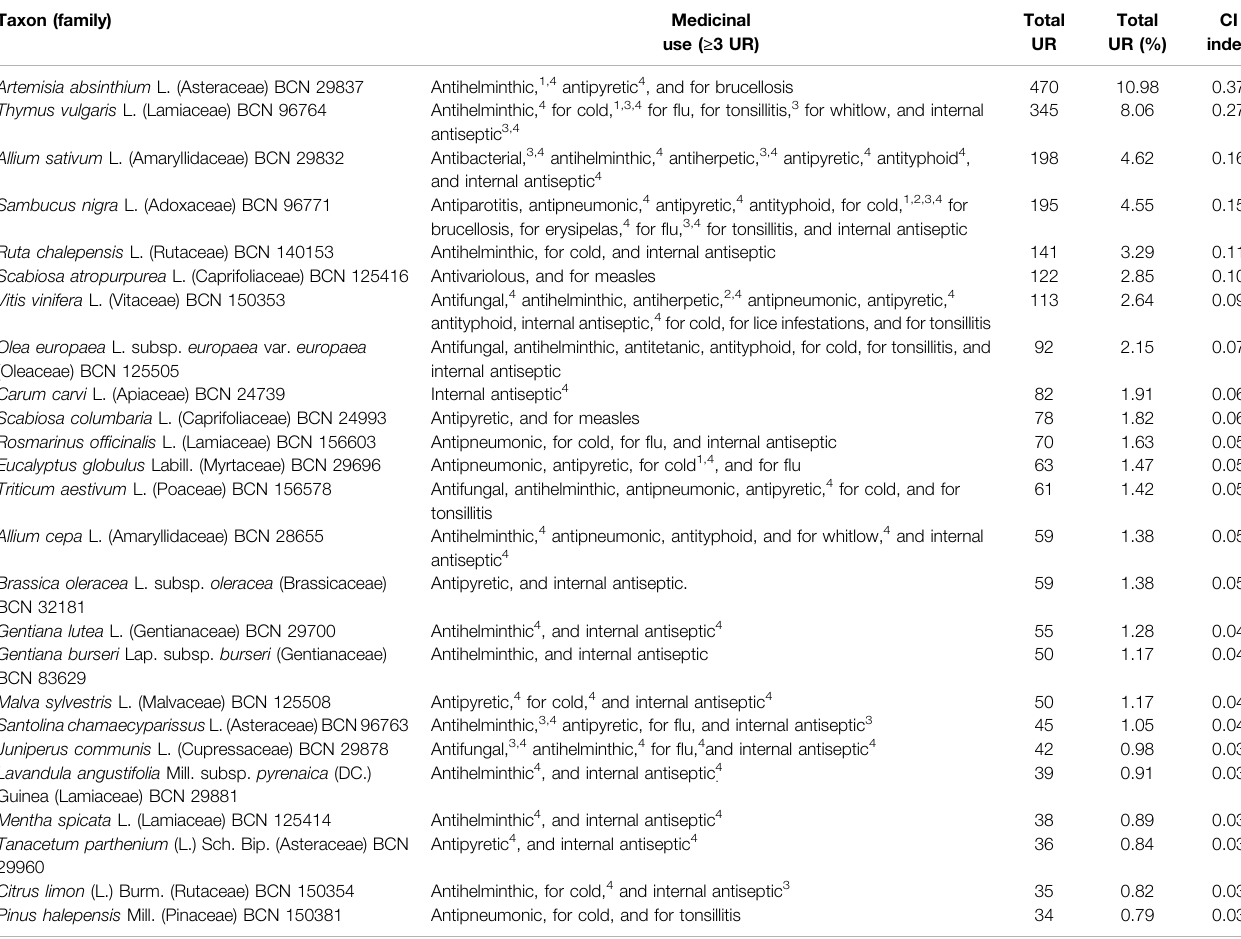
TABLE 1| 25mostquoted plantsusedforinfectionand infestationinthestudied area,withthemostquoted medicinaluses( ≥ 3UR)andthenumber oftotalusereports and percentage. Comparation of uses in pharmacological comprehensive literature: 1 EMA (European Medicines Agency), 2021, 2 ESCOP (European Scienti fi c Cooperative on Phytotherapy), 2021, 3 Fitoterapia.net (2021), 4 Duke